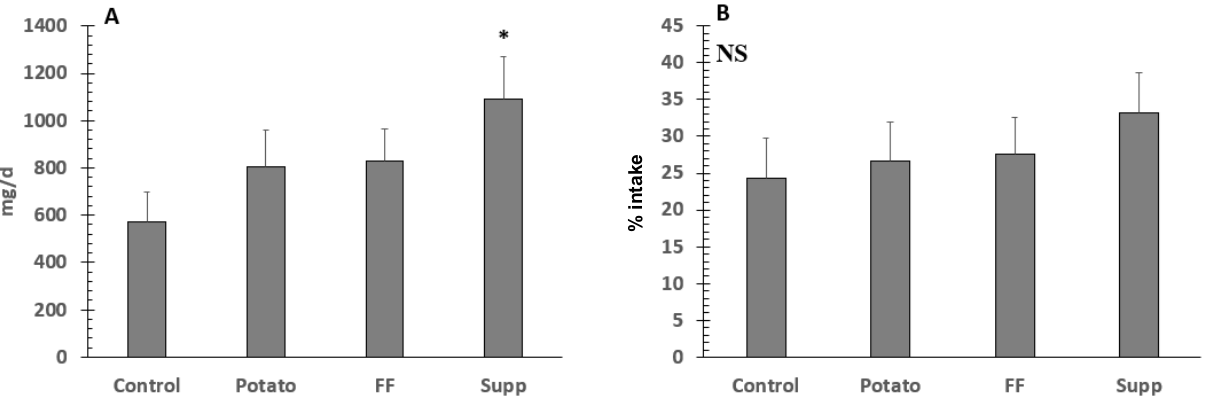
Figure 6. Potassium retention as mg/d ( A ) and percent (%) of intake ( B ) in hypertensive adults on a controlled diet. * denotes significant difference ( p < 0.05) between supplement and other groups. NS, not significant differences. To convert to mmol/d, divide by 39.